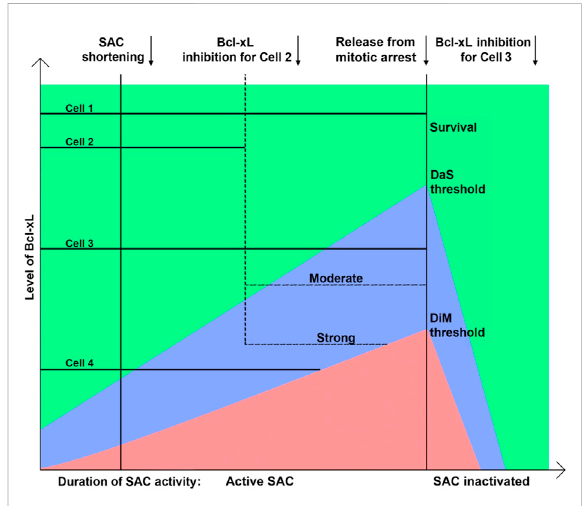
FIGURE 6 Model explaining the regulation of the outcome of mitotic arrest by the Bcl-xL level and duration of mitotic arrest. After release from mitotic arrest cells divide or undergo mitotic slippage and rapidly restore anti-apoptotic proteins activity. Death after slippage area is shown in blue; death in mitosis is shown in red. Cells ’ fates can be shifted from survival to death in mitosis or death after slippage by inhibiting Bcl-xL to a certain